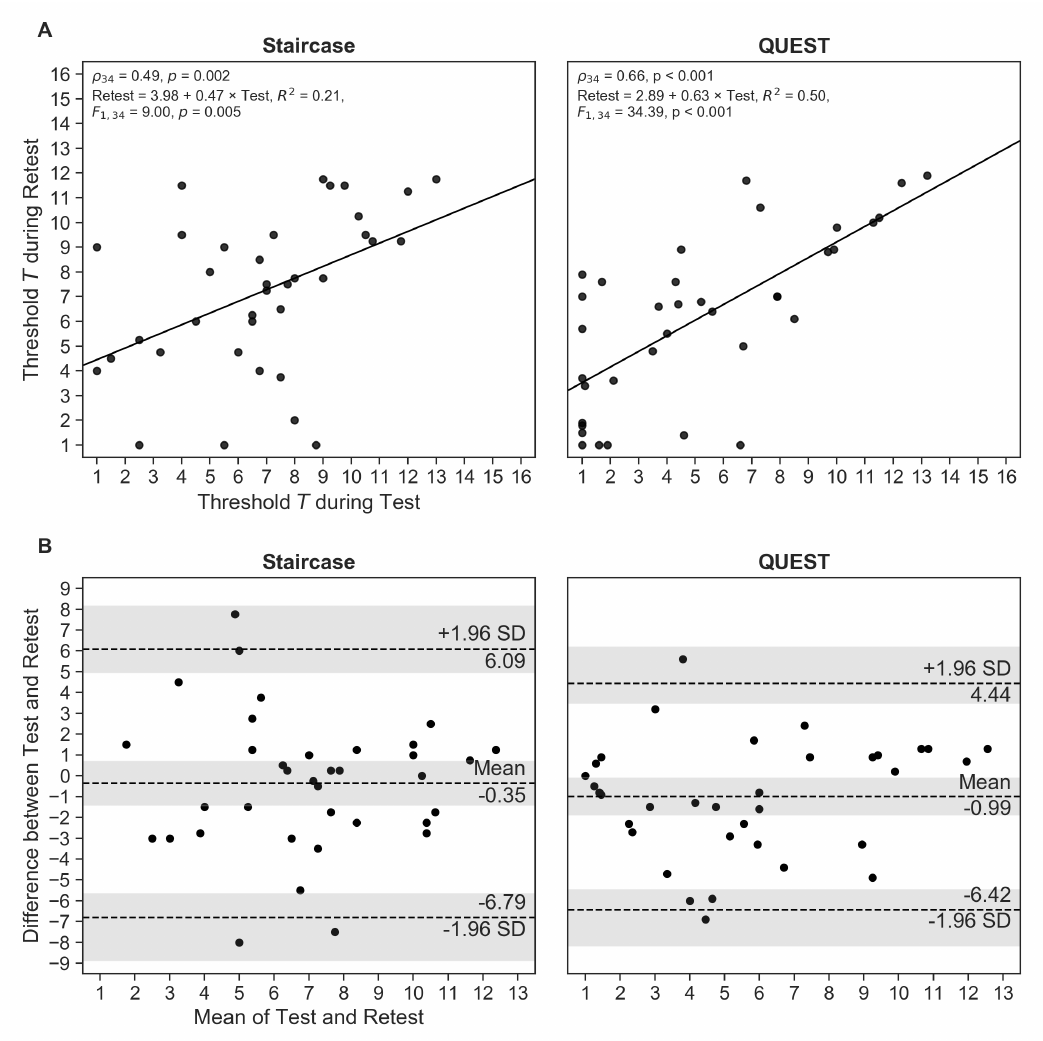
Figure 2. ( A ) Correlation between Test and Retest threshold estimates for the staircase and QUEST procedures. ( B ) Bland–Altman plots showing mean differences between Test and Retest, and limits of agreement corresponding to 95% confidence intervals (CIs) as mean ± 1.96 × SD. The shaded areas represent the 95% CIs of the mean and the limits of agreement. Each dot represents one